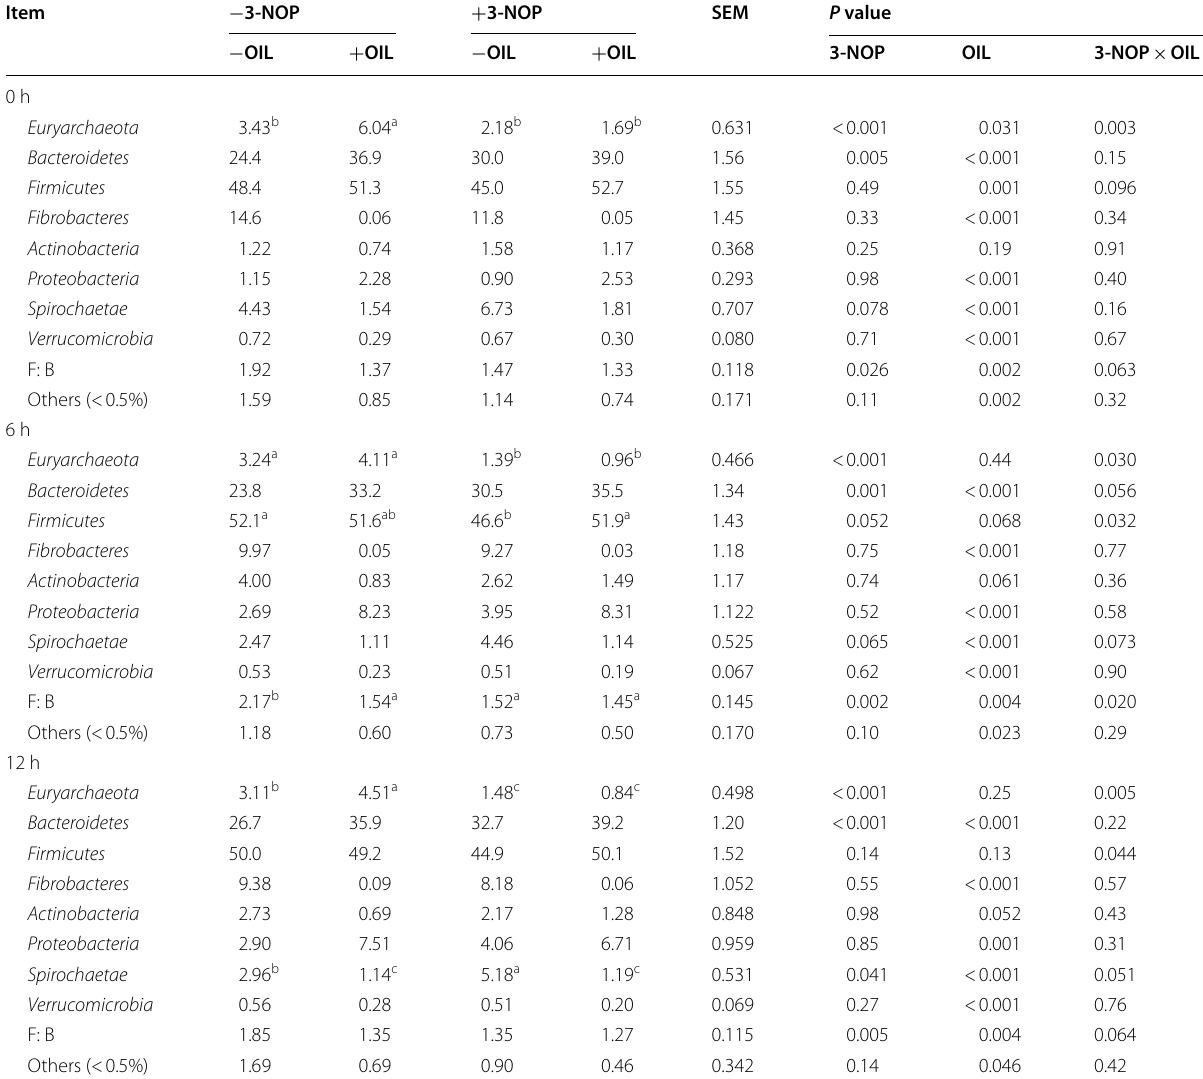
Table 3 Impact of feeding diets supplemented with ( in rumen digesta in beef cattle at 0, 6 and 12 h after